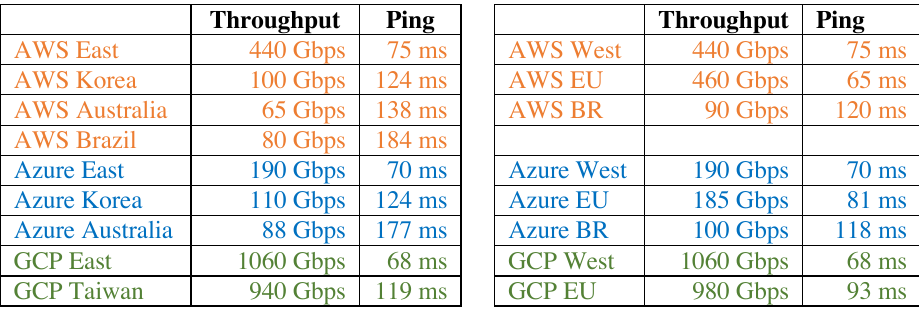
Table 1. Peak observed throughput and ping times between Cloud regions within a commercial Cloud provider. a) Left, endpoint in the US West region. b) Right, endpoint in the US East region. Throughput Ping Throughput